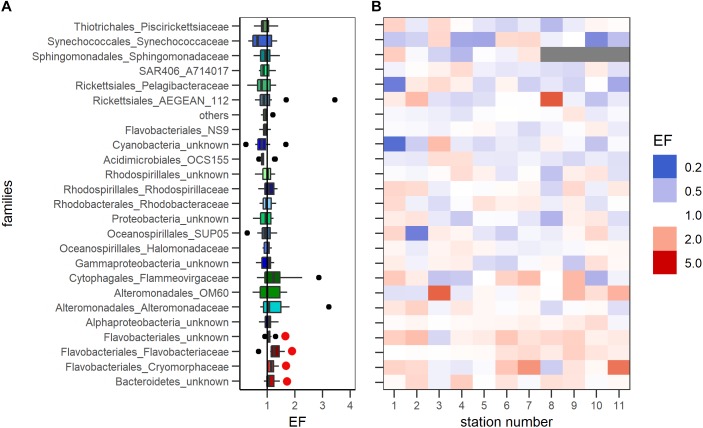
| Enrichment of bacterial families that make up at least 1% of the total bacterial community in at least two stations. (A) Enrichments during the whole cruise (11 stations) were combined. Red, Bacterial families that were significantly enriched in the SML. blue/green, bacterial families that showed no significant changes with depth. Black line indicates no change between depths (EF = 1). Black circles, outliers. Red dots mark significant enrichment of bacterial families throughout the cruise. (B) Enrichment of families according to each individual station. Blue indicates a depletion, white no change and red an enrichment of a certain bacterial family at the respective station. An EF of 0.2 indicates a five-fold decrease, an EF of 5 a five-fold increase of a certain bacterial species in the SML.